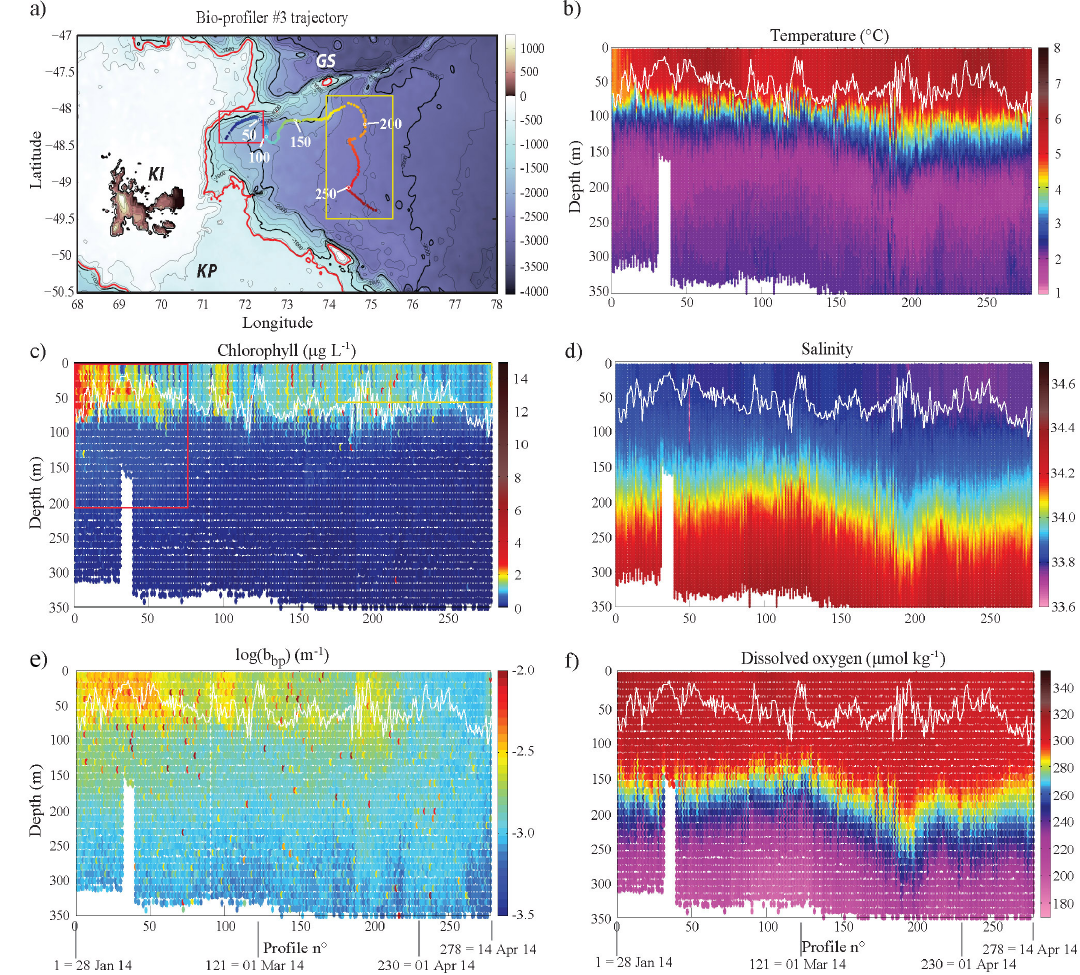
Figure 5. Same as Fig. 3 but for bio-profiler